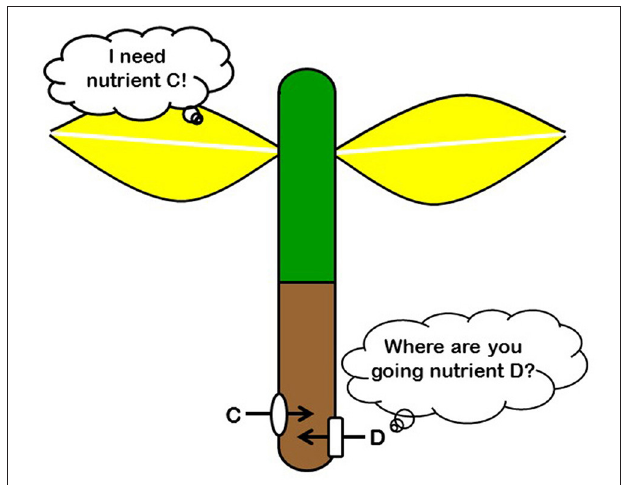
FIGURE 1 | The responses to the deficiency of a particular nutrient can promote the acquisition of such a nutrient but also the acquisition of other